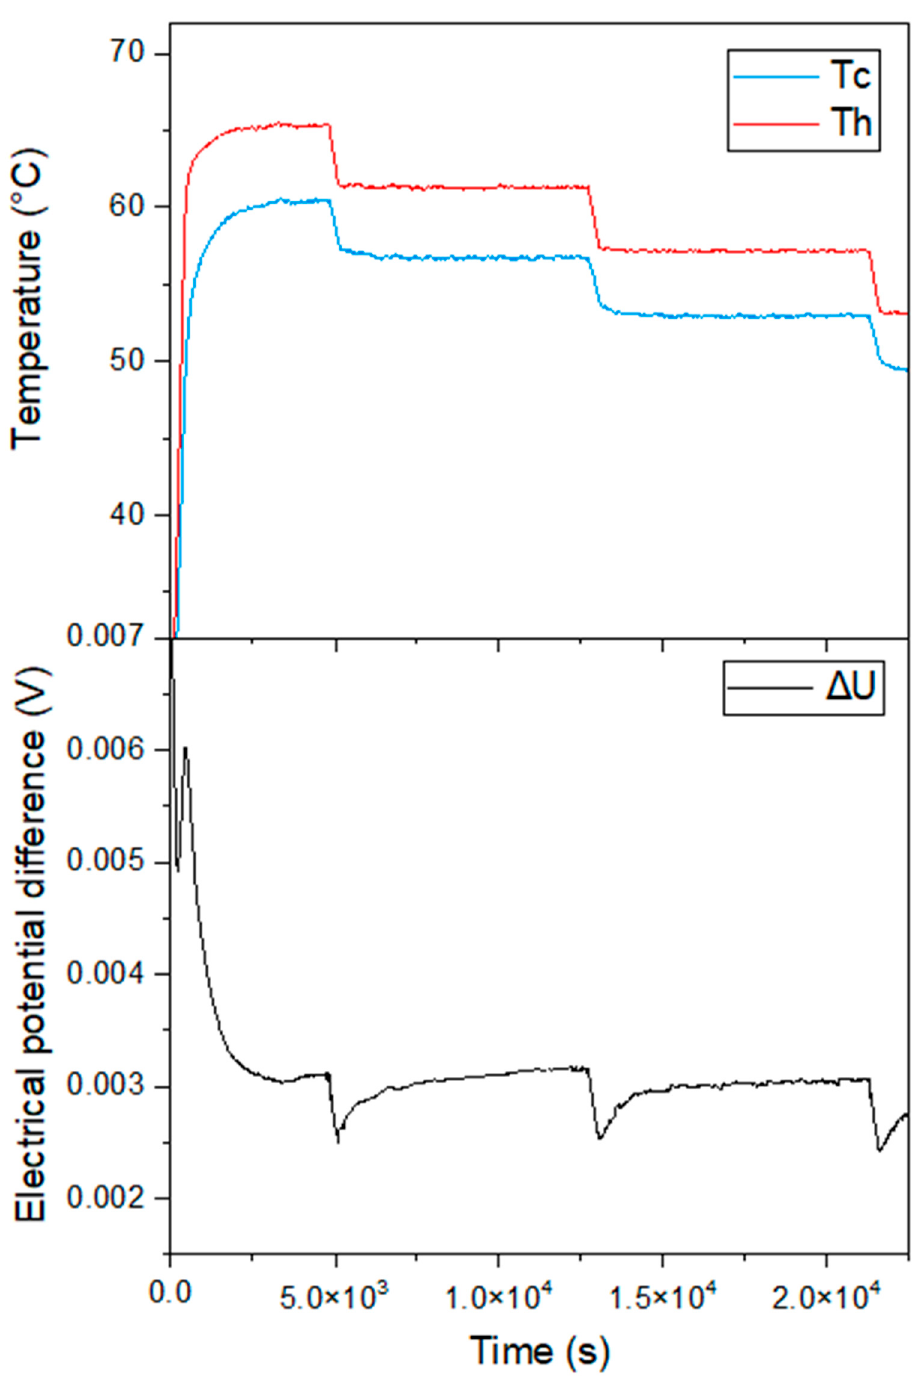
Figure 9. Example of cooling sequence for establishing Δ T in a temperature range from 70 to 50 °C for PSi-7 and measurement of Δ U.